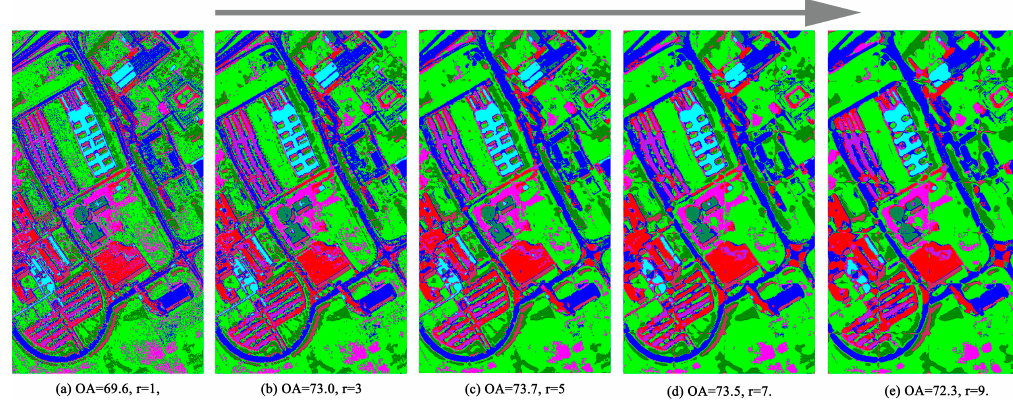
Figure 13. Classification maps based on the proposed system using MLC classifier. The fixed object size of OSSD-based processing is 90, and the value of window size for median filter ( a – e ) varies from 1 to 9.